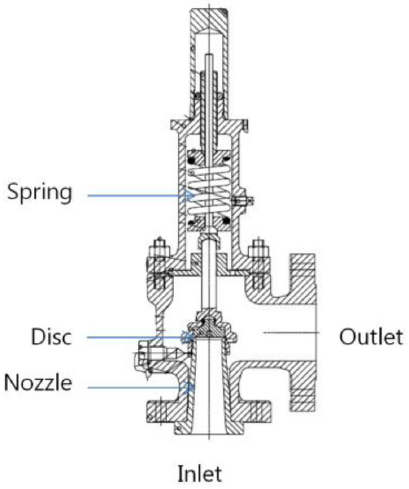
Figure 1. Schematic diagram of typical pressure relief valve.